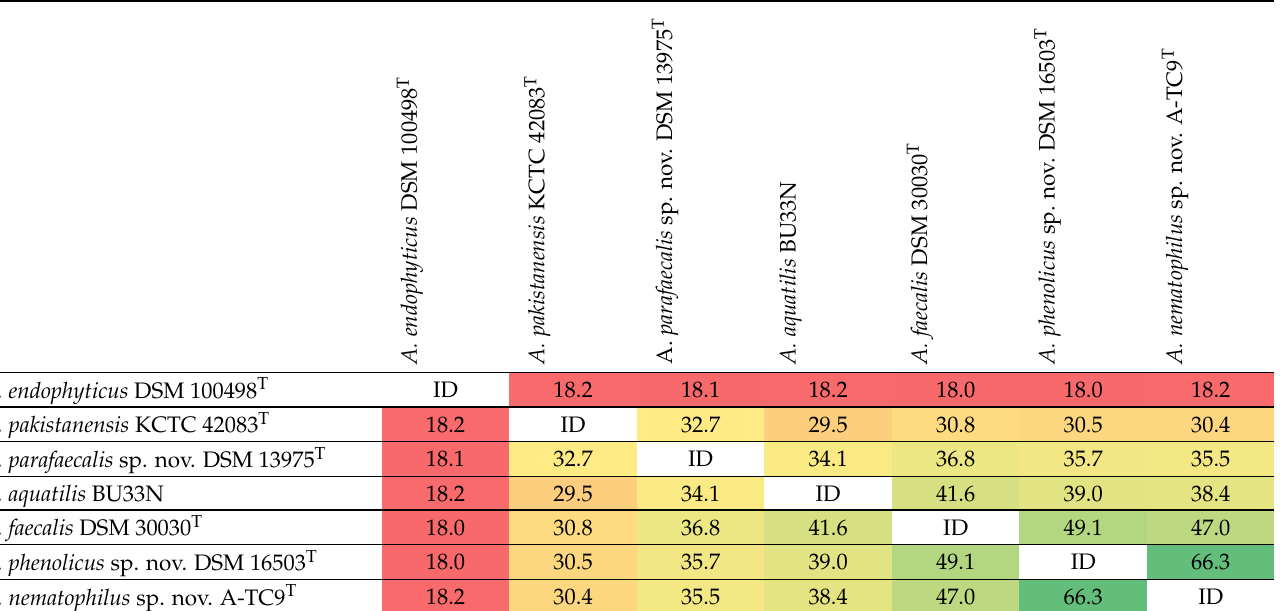
Figure 2. Phylogeny based on core genome sequences of all the species of the genus Alcaligenes. 408607 nucleotide positions (399 core genes) were used in the analyses. Numbers at the nodes represent SH-like branch supports. Phylogenomic trees were built using FastTree 2.1.10 based on the Generalized Time Reversible Model (GTR) [61]. Accession numbers of the sequences used in the analyses are shown in Table S1. Bold indicates novel taxonomic proposals. Table 2. Pairwise comparison of digital DNA-DNA Hybridization (dDDH) scores (%) of all the species of the genus Alcaligenes . Accession numbers of the sequences used in the analyses are shown in Table S1. Colors indicate the degree of relatedness between bacterial species pairs.